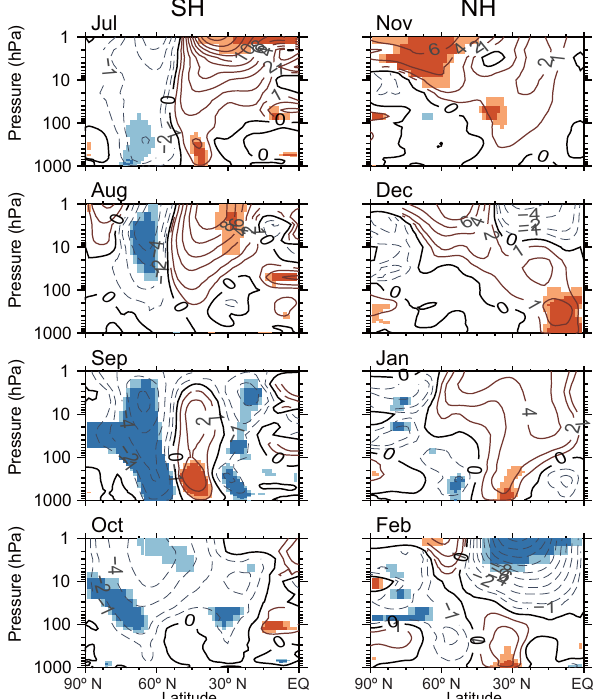
Figure 6. Monthly solar regression coefficient of zonal mean zonal winds in (left) July, August, September and October in the SH, and (right) November, December, January and February in the NH. Solid (dashed) contours indicate positive (negative) values and are drawn every 1ms − 1 . Areas of 90 and 95% statistical significance are shown by light and dark shading, respectively, in red (positive) and blue (negative).